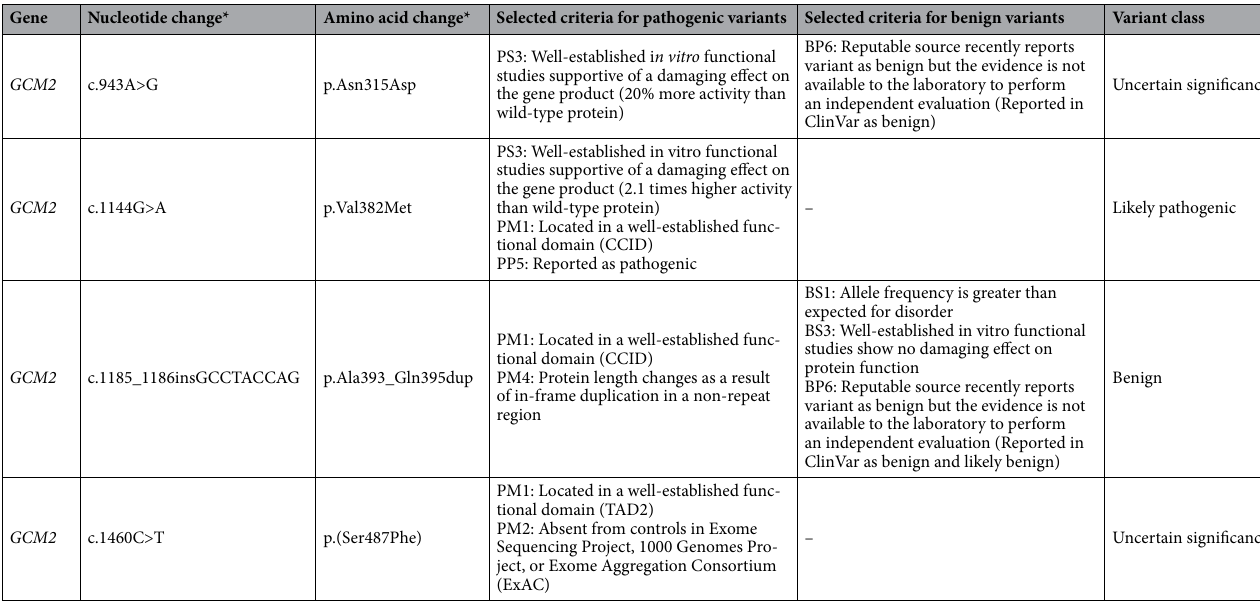
Table 2. GCM2 variants classification according to the ACMG guidelines. *Numbering is according to DNA sequence (Ensembl: ENST00000379491.5 for the GCM2 gene), all in heterozygous. TAD2